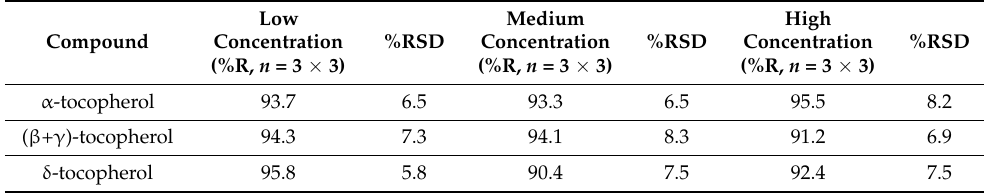
Table 3. Recovery (%R) rates for the evaluation of the